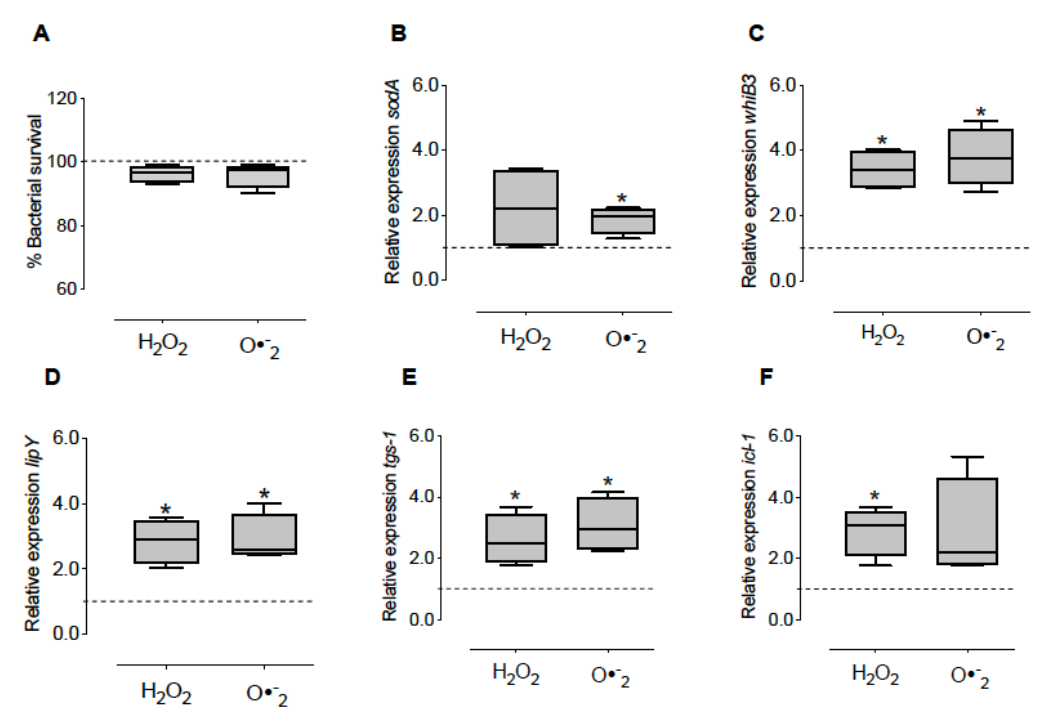
Figure 5. Effect of oxidizing agents on bacterial survival and gene expression of M. tuberculosis . Bacteria were grown in the presence of 5 mM H 2 O 2 and O 2 •− generator system for 2 h. Then, we determined the survival ( A ) and the expression of sodA ( B ), whiB3 ( C ), lipY ( D ), tgs-1 ( E ) and icl-1 ( F ). The data show the maximums and minimums by quartiles. * p < 0.05 significant difference compared to the expression of the control, n = 4. The dashed horizontal line represents the median of the control, and the Wilcoxon test was used to compare against the control (untreated mycobacterial culture).